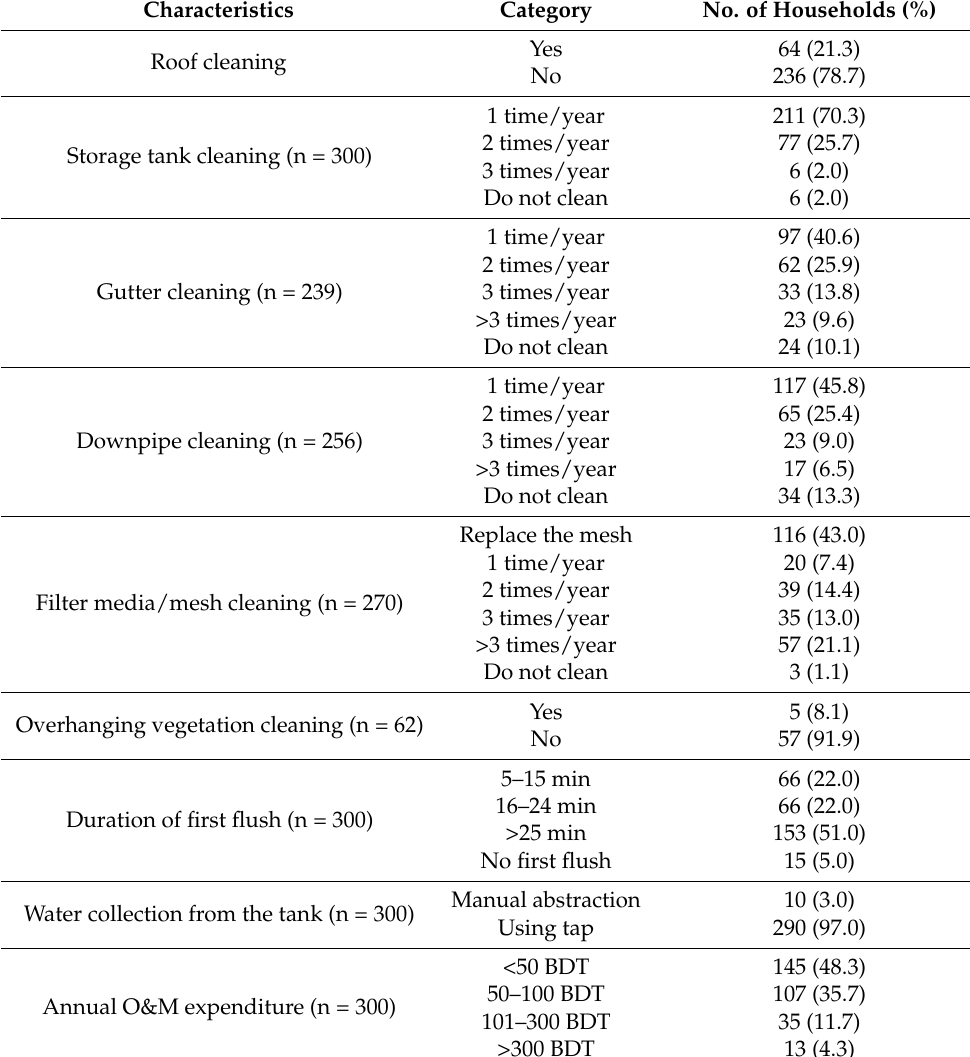
Table 5. Rainwater management practices of the